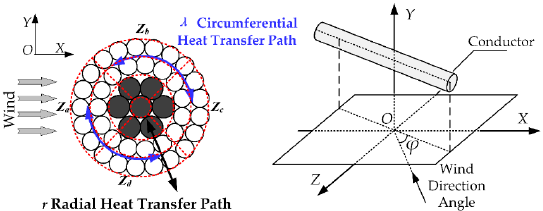
Figure 2. Heat transfer analysis and geometric division of overhead transmission line